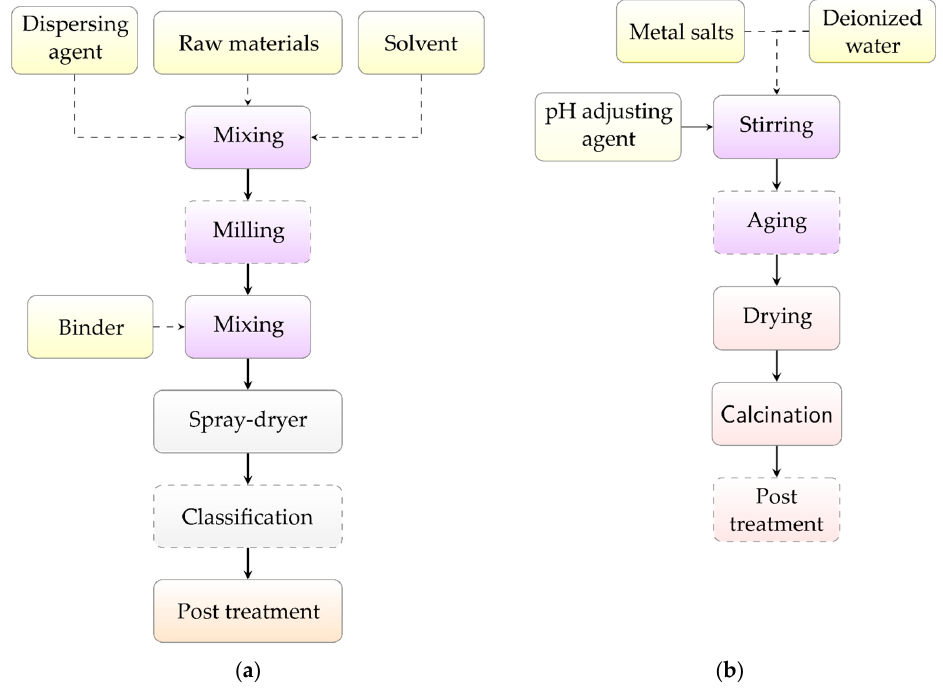
Figure 17. A simple flowchart of the spray-drying process ( a ) and of the coprecipitation process ( b